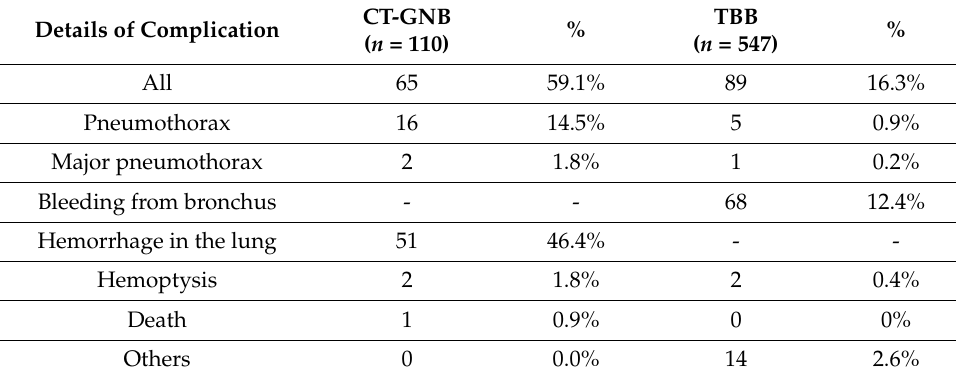
Table 5. Occurrence of complications with CT-GNB and